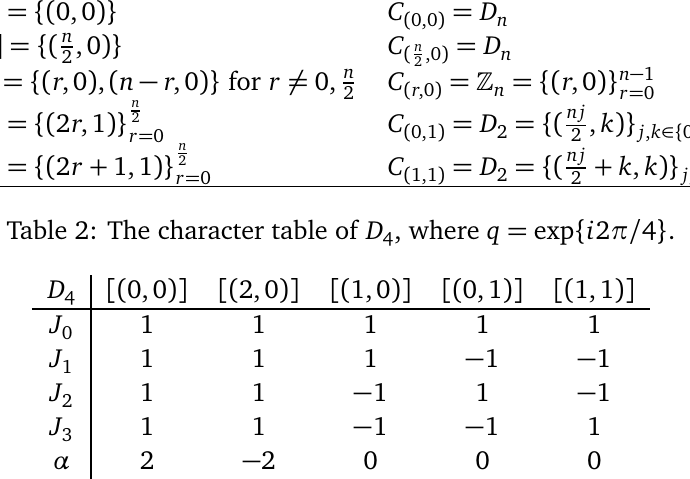
Table 1: Conjugacy classes of the dihedral group D